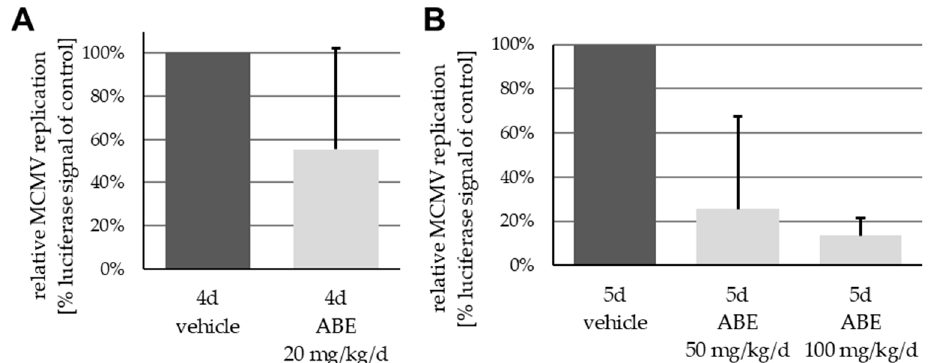
Figure 2. In vivo antiviral drug dosage assessment: ABE-mediated concentration-dependent reduction of spleen-specific MCMV viral load. Oral application of ABE in dosages of ( A ) 20 mg/kg/d over 4 days and ( B ) 50 mg/kg/d or 100 mg/kg/d over 5 days, resulting in a reduction in viral load of 44%, 74% or 87%, respectively, compared to vehicle-treated animals. Data are presented as mean + SD of viral replication across five animals per group as measured using in vitro luciferase assay performed on spleen homogenates.